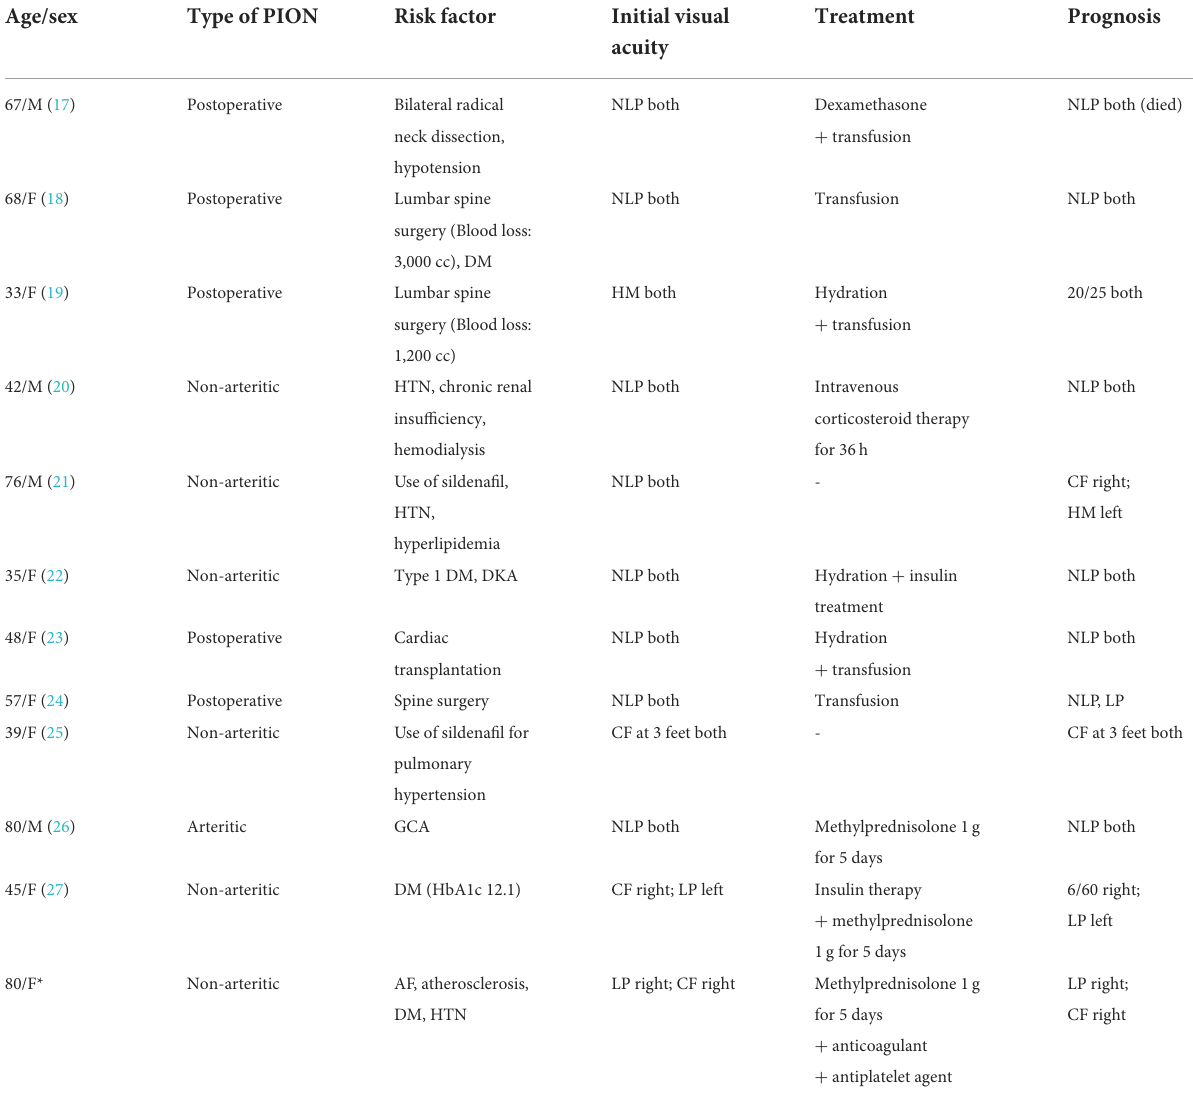
TABLE 1 Characteristics of reported bilateral sequential PION